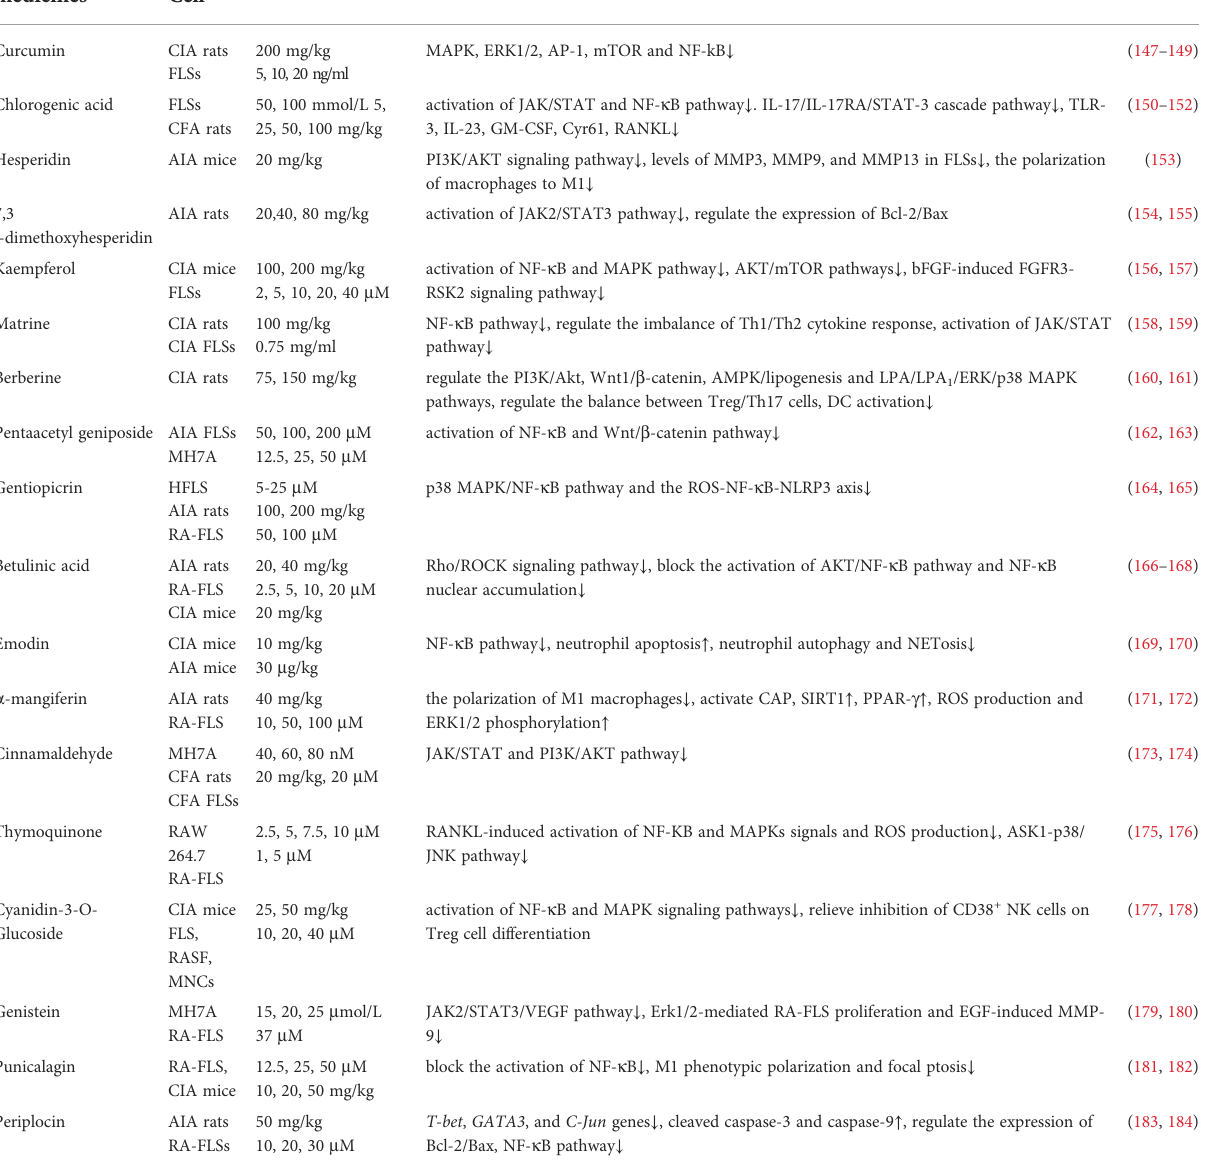
TABLE 1 Other Natural medicines of targeted RA and their mechanism of